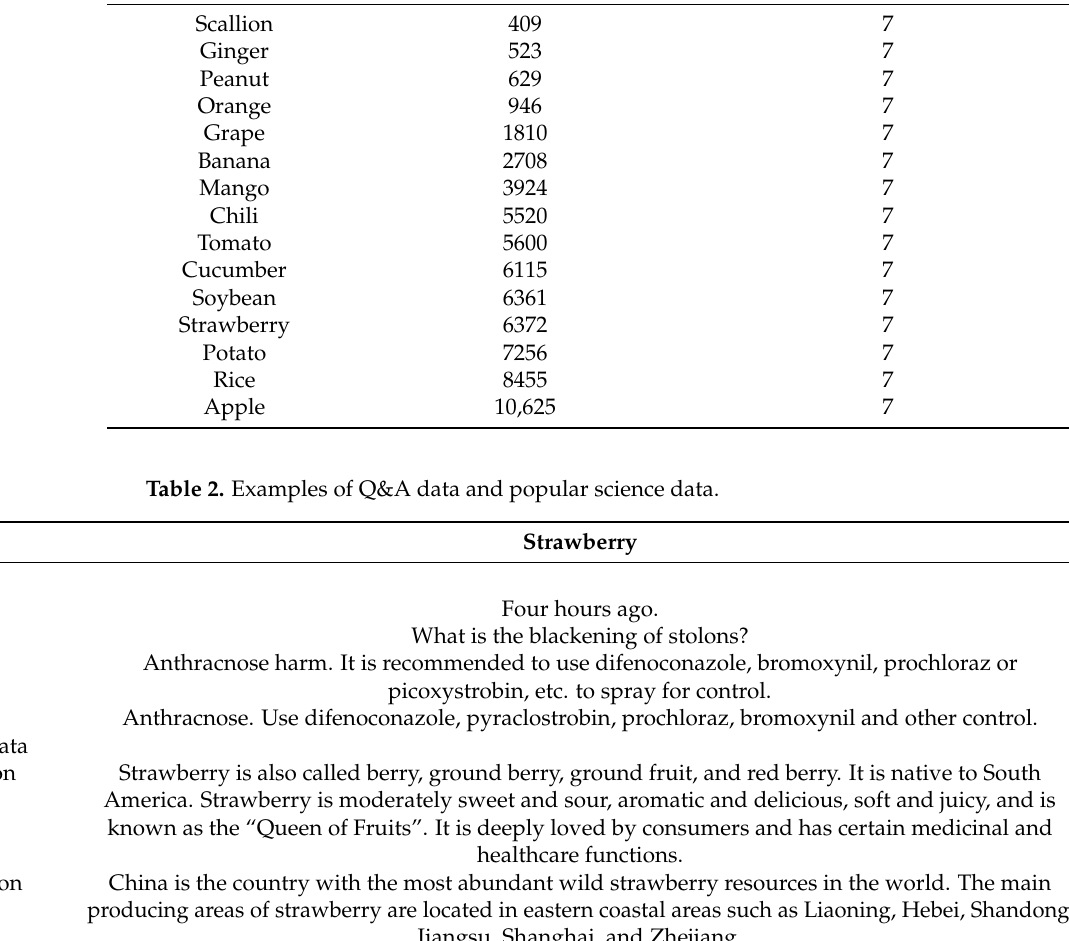
Table 1. Statistical table of question-and-answer (Q&A) data and popular science data. Crops Amount of Q&A Data Amount of Popular Science Data